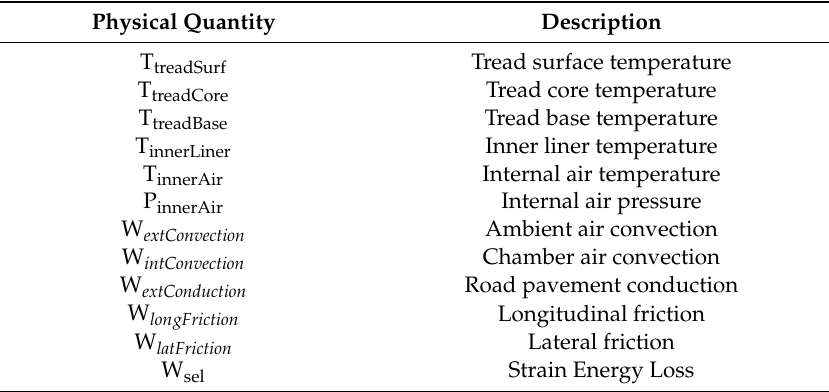
Table 2. thermoRIDE model